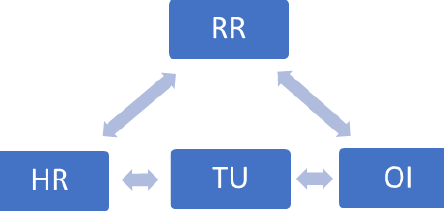
Figure 2: Synthetic learning